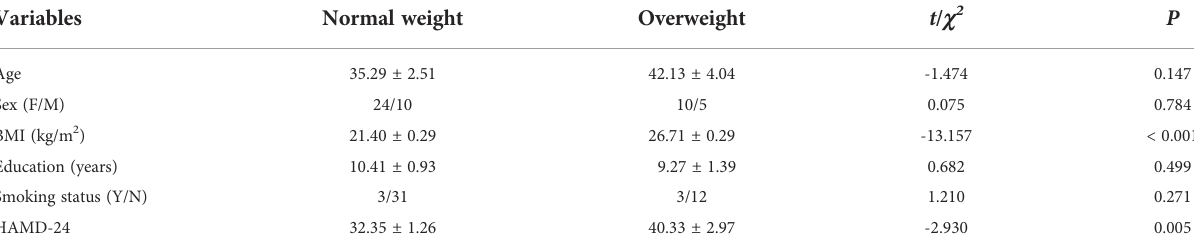
TABLE 2 Demographic and clinical characteristics of normal-weight patients with MDD and overweight patients with